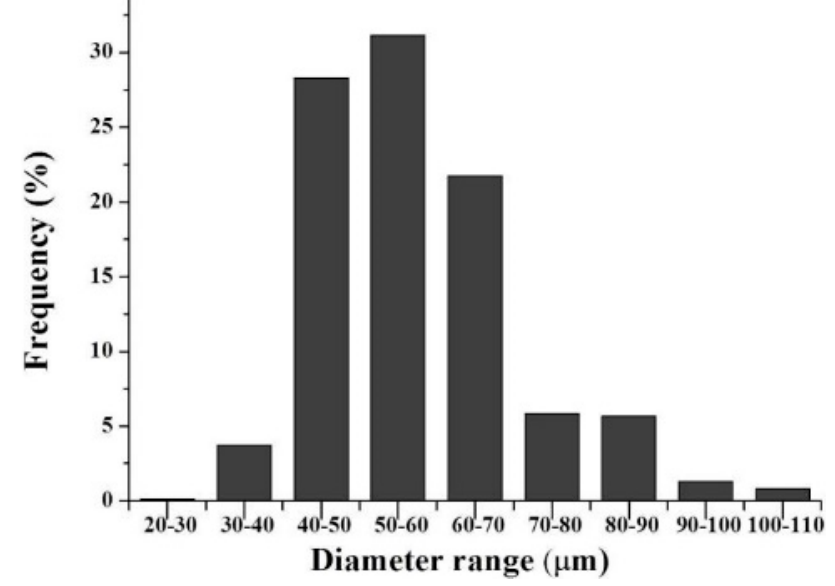
Figure 2. Size distribution diagram of the PLGA microspheres.